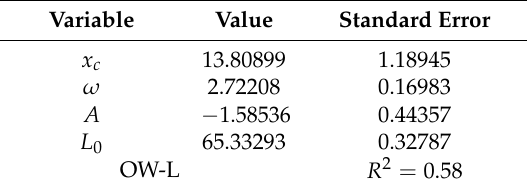
Table 13. Correlation modeling between Temperature and Noise Level at OW-L.